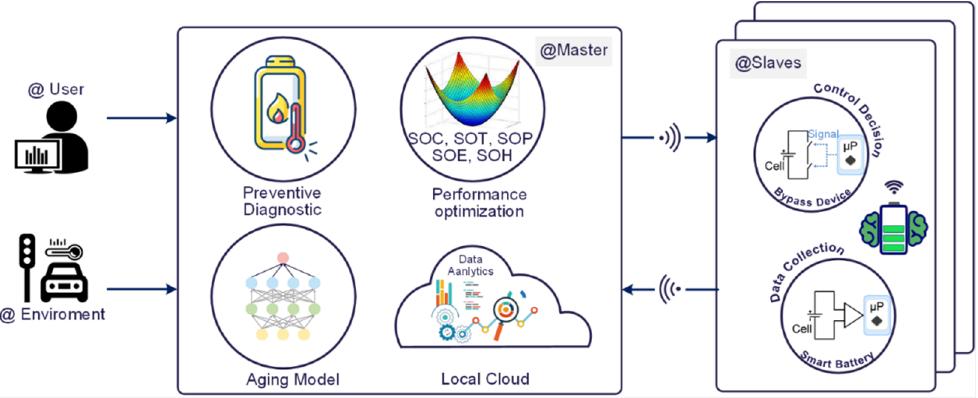
Figure 14. A detailed overview of the Smart Battery system with various attributes including opti ‐ mization of SOX (SOP, SOE, SOT, and SOH). Based on whether the performance is optimized or not, the bypass switches act to activate or provide rest to a cell. The cell aging model is built on AI trained neural network blocks that fully emulate a real battery aging mechanism for given user load profiles and desired performance with a given aging condition of the battery as the initial state of operation.